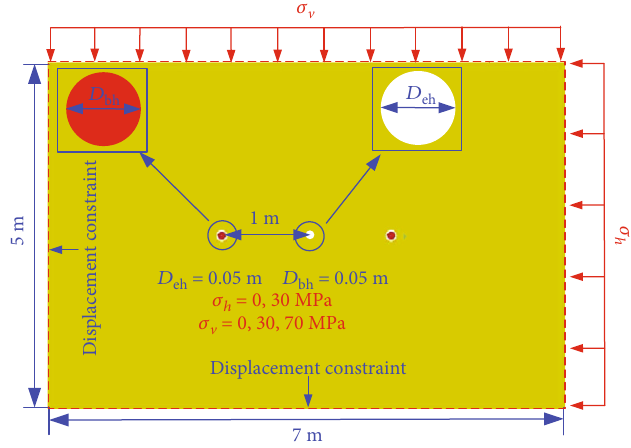
Figure 8: Blasting model with empty